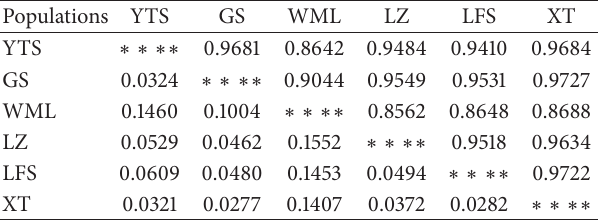
Table 6: Nei’s genetic identity (above diagonal) and genetic distance (below diagonal) in